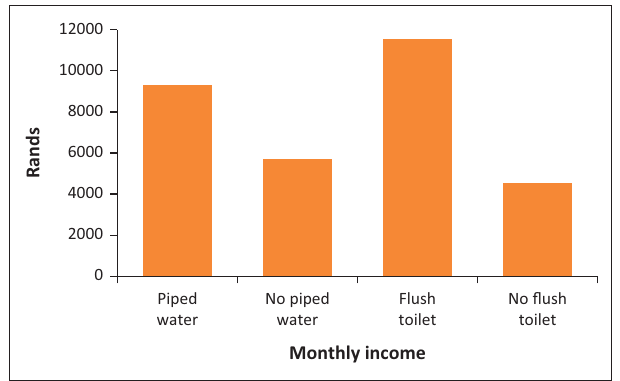
FIGURE 5: Average monthly household income (incl. grants).